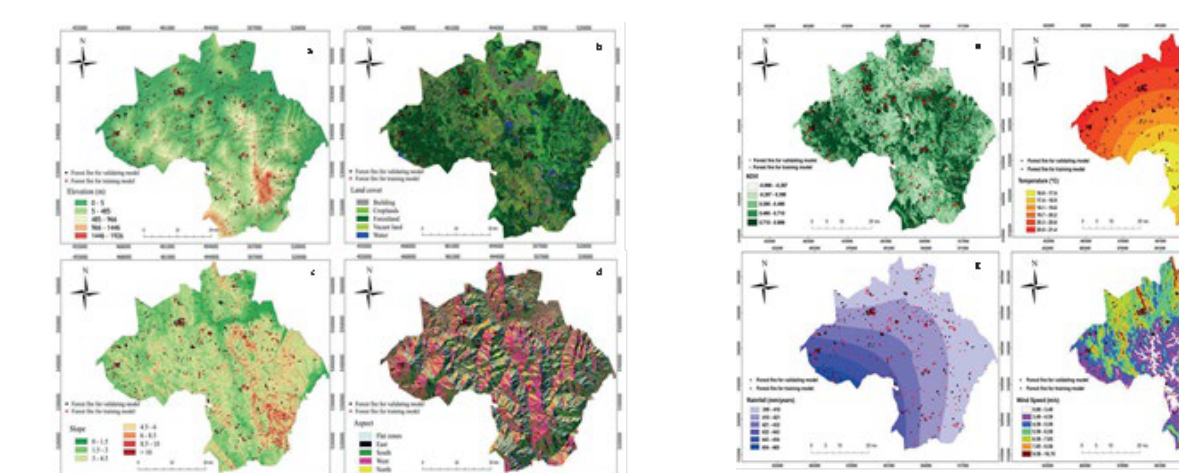
Figure 3. Fire conditioning factors (e. NDVI; f. Temperature; g. Rainfall; h.Wind Speed)